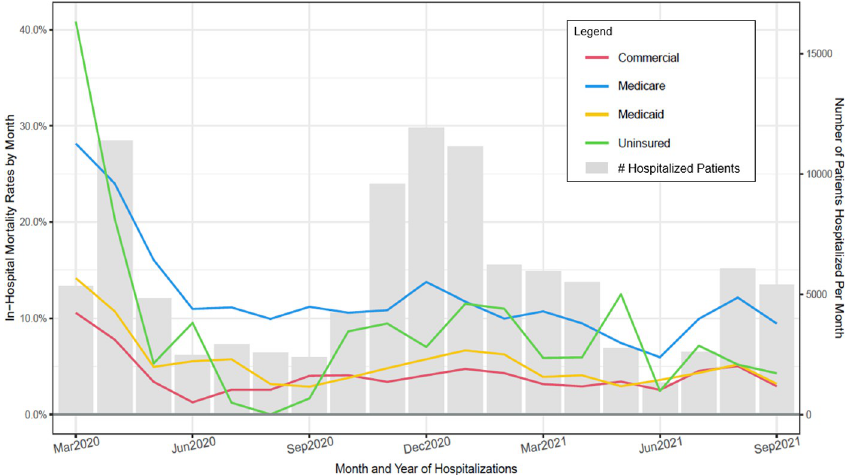
Fig 8. Observed in–hospital mortality rates (Deaths/hospitalizations) and number of patients hospitalized per month for patient insurance status groups (March 2020 through September 2021).